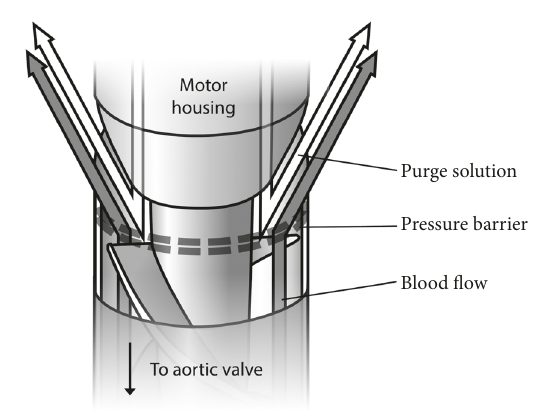
Figure 1: Impella Outlet Area. The Impella purge solution is released from the motor housing in a countercurrent direction to the flow of blood being expelled from the left ventricle. The resulting pressure barrier prevents blood from entering the motor housing (image created by the